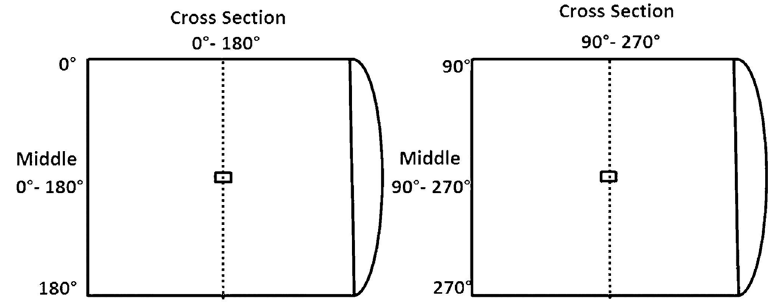
Figure 3. Measuring positions of Vickers hardness (HV0.5).